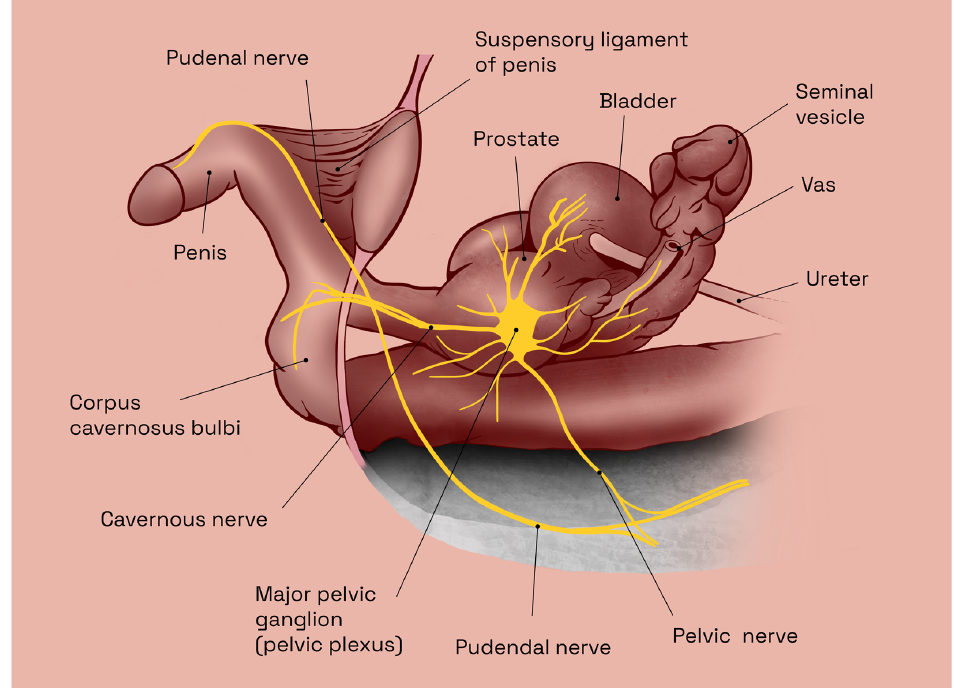
Figure 5. Lateral view of rat model pelvic anatomy. Illustration adapted from Quinlan et al.